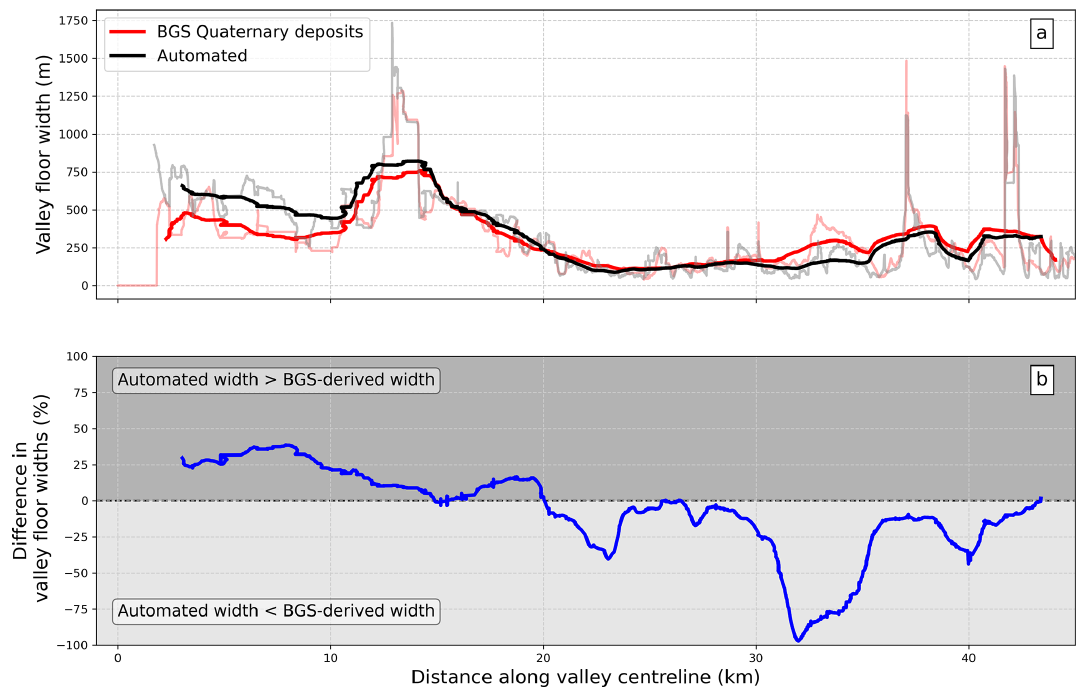
Figure 5. Results of valley floor width comparison for the River Tweed. (a) Valley floor width from upstream to downstream along the centreline for the automated method (black) and derived from the BGS Quaternary maps (red). The light grey and red lines show the raw data, and the darker lines show a rolling average of width over a 500m window. (b) Percentage difference between the two datasets along the centreline, where positive values indicate a wider automated width than BGS derived, and negative values indicated a narrower automated width than BGS